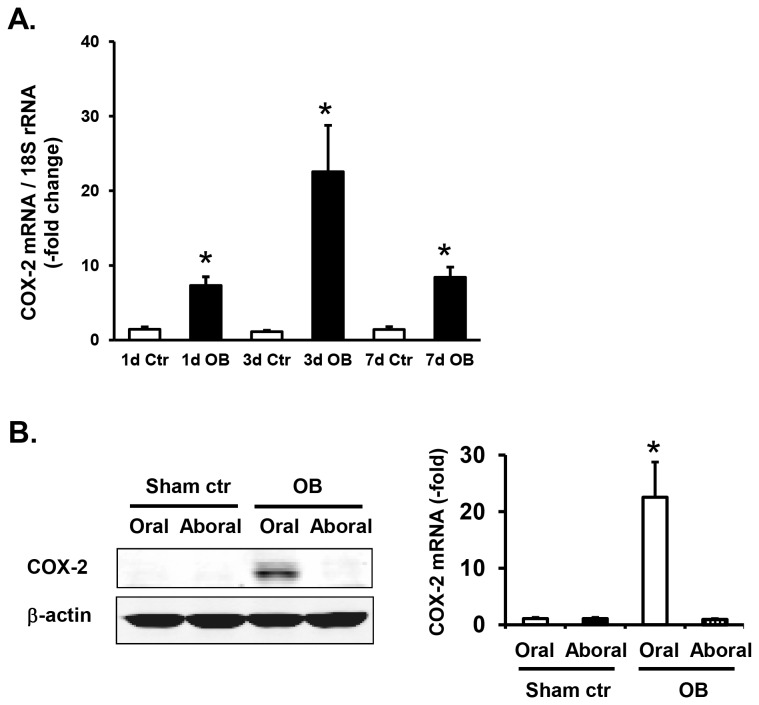
COX-2 gene expression in partial colon obstruction in wild-type mice.(A) Colonic muscularis externae was isolated from the segment proximal to obstruction in mice with sham and obstruction for different days. The COX-2 mRNA levels were measured by real-time qPCR. Note that the COX-2 mRNA expression increased in obstruction (OB) at all time points. * p < 0.05 vs. sham controls of the group. No significant difference was found among the OB groups in different days. N = 4 to 6 for each group. (B) Expression of COX-2 protein and mRNA in the segments oral and aboral to obstruction on day 3. Note that obstruction leads to a marked increase of COX-2 expression in the segment oral to obstruction, but not in the segment aboral to obstruction. * p < 0.05 vs. oral in sham controls. N = 4 to 6 for each group.